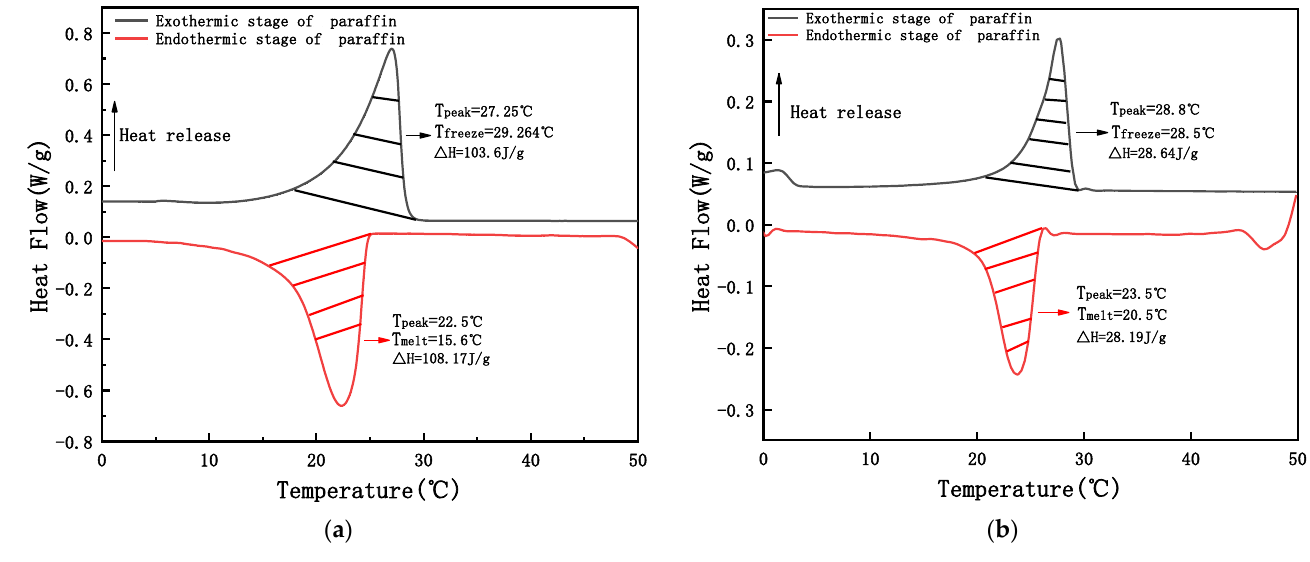
Figure 9. DSC curves of ( a ) paraffin and ( b ) ESPBG.